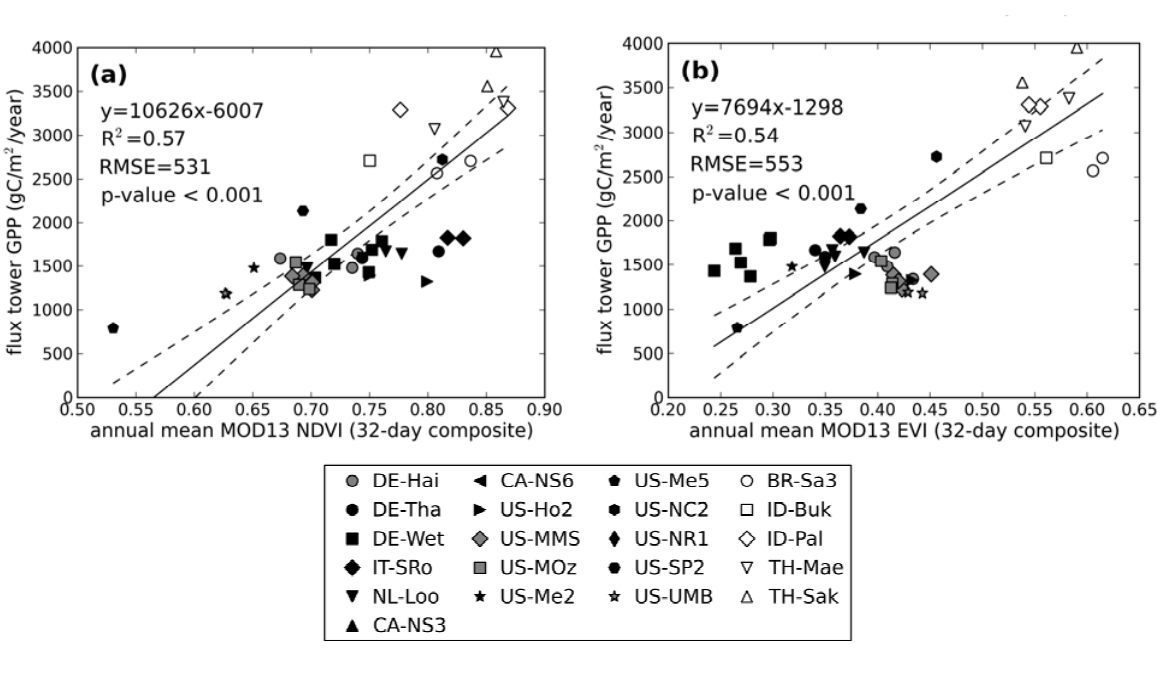
Figure 4. Scatterplot of annual mean MOD13 NDVI ( a ) and EVI ( b ) against flux tower annual GPP. NDVI and EVI data were processed to a 32-day maximum value composite (MVC) before calculating the annual mean value. The solid line represents the reduced major axis regression between the variables. The dashed lines are 95% confidence interval lines. Multiple points for a given site correspond to data from different